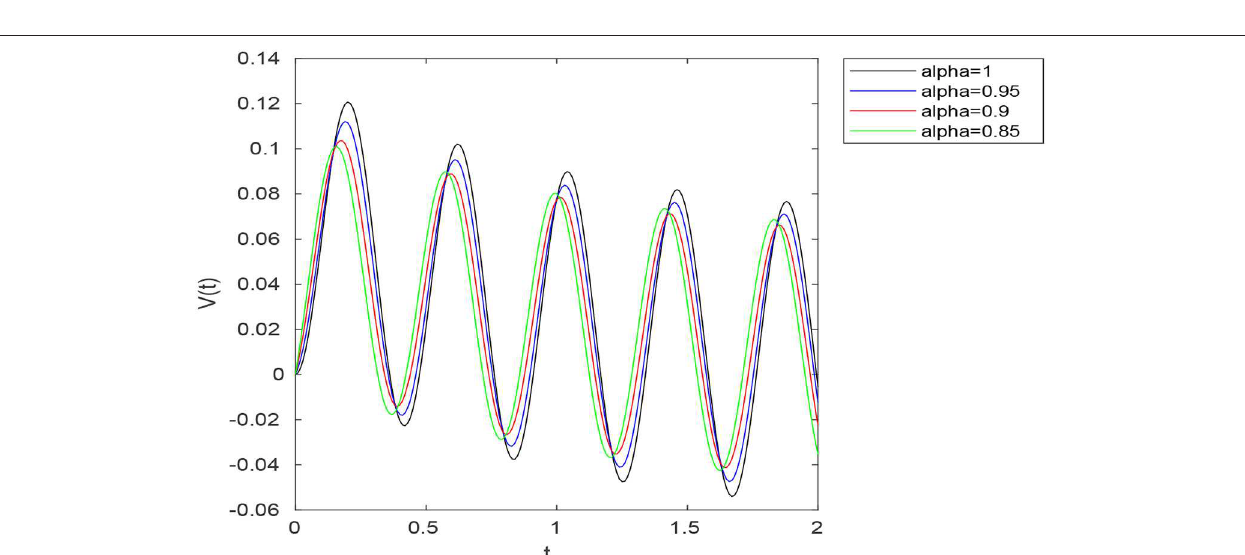
sin(15 t ) and ( a , b ) (2, √ 2). = =